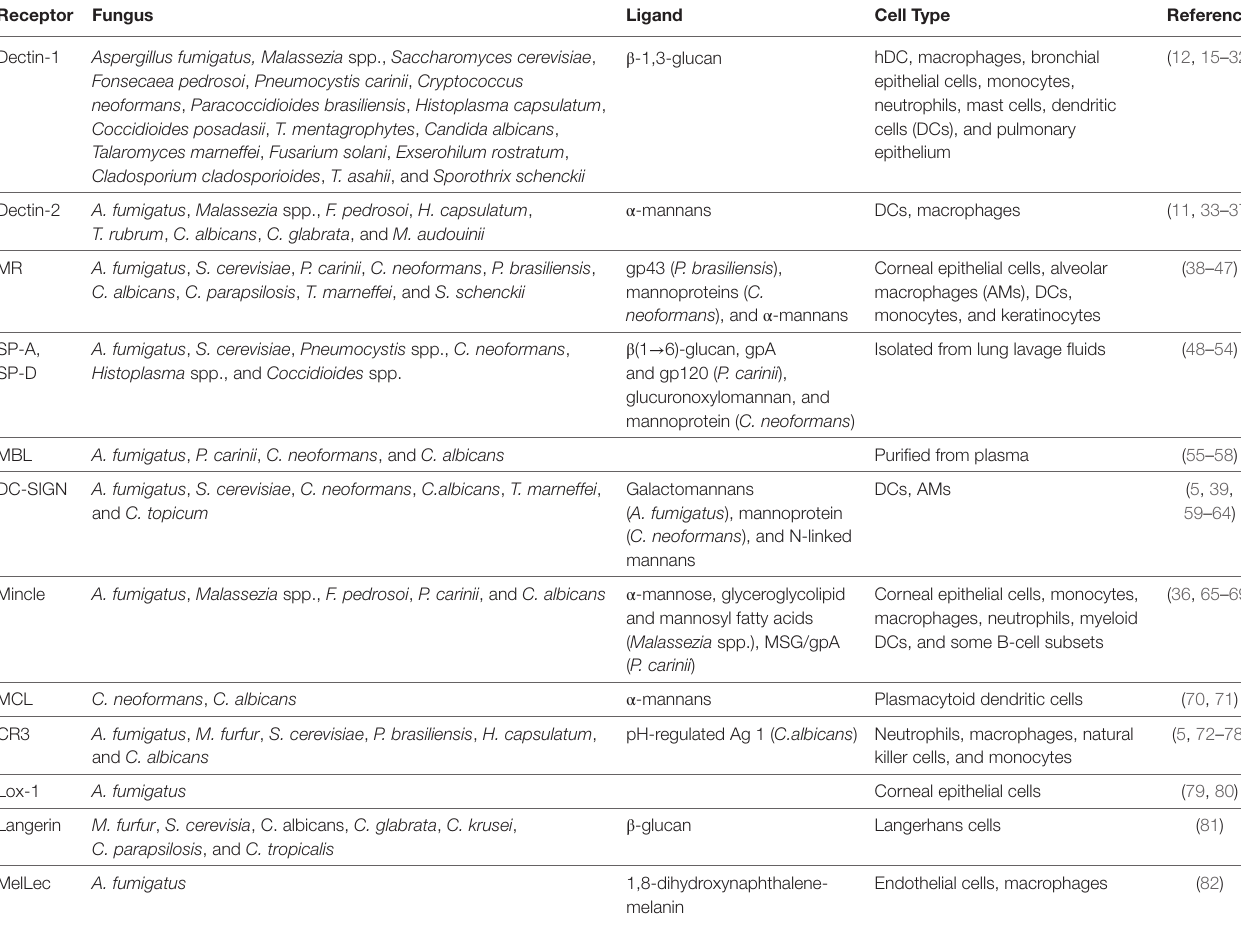
TABLe 1 | C-type lectin receptors and their respective ligands involved in fungal recognition by different human cell types. Receptor Fungus Ligand Cell Type Reference